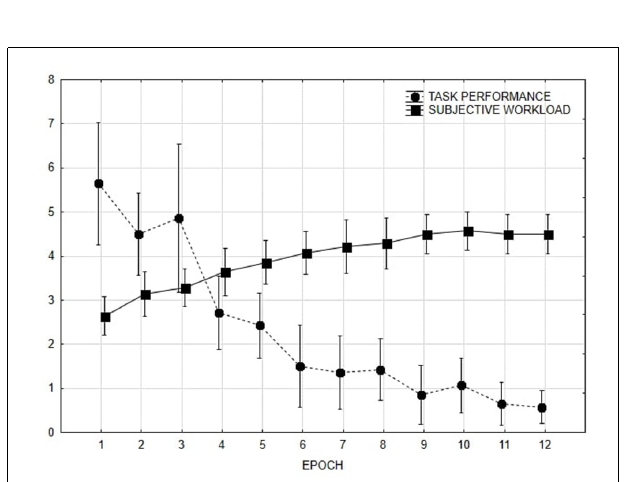
FIGURE 8 | Task performance (number of differences found) and subjective workload (ratings from 1 to 5) along time. Error bars denote 0.95 confidence